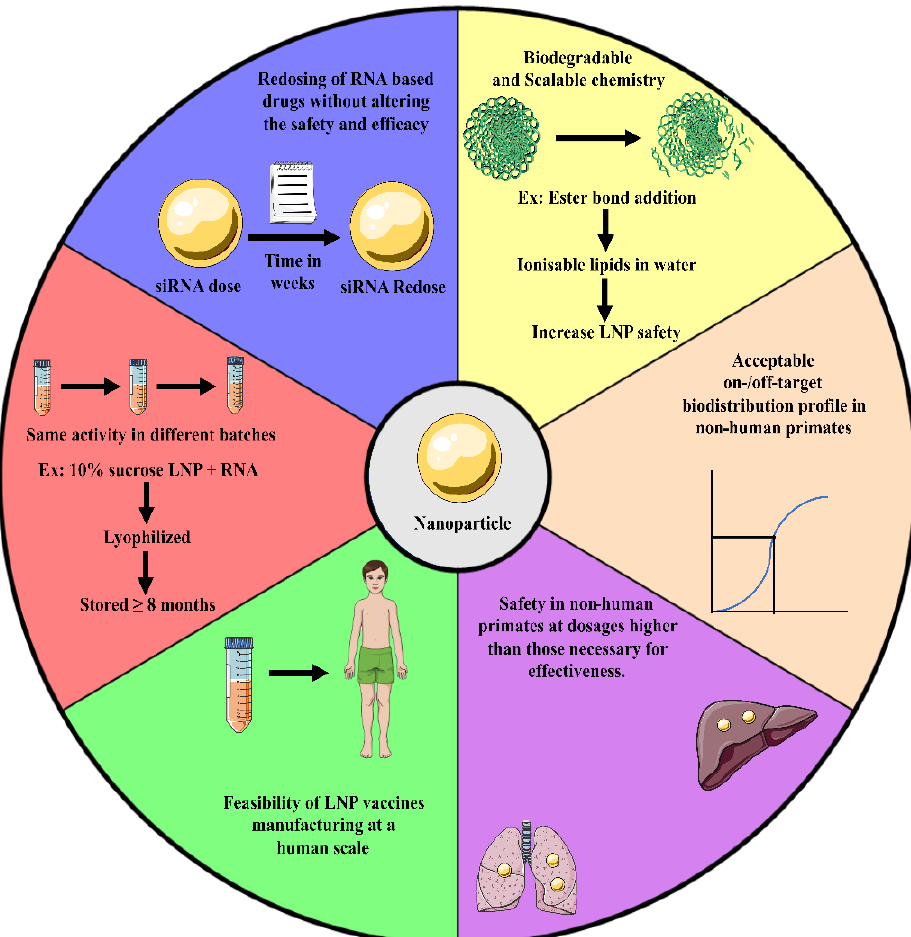
Figure 6. Any RNA-based vaccine delivery during its development must possess the 6 mentioned ideal characteristics (approved by FDA/EUA) so as to exert clinical relevancy and reach the pharmaceutical market.